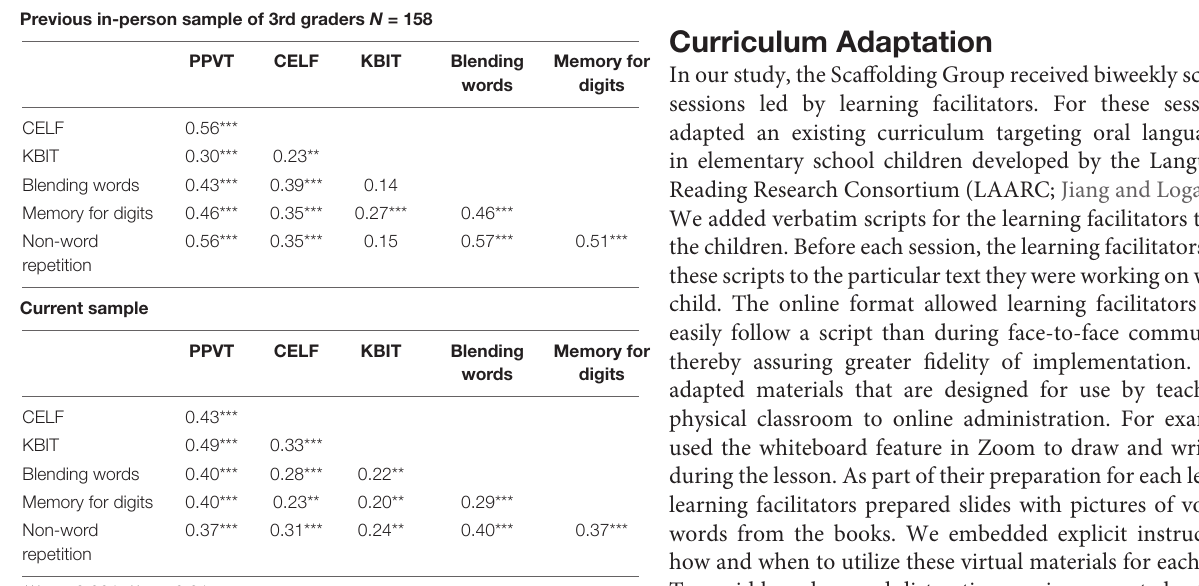
TABLE 5 | Pairwise correlations among a sample of six variables from the current study and a comparable pre-pandemic in-person study from the same research